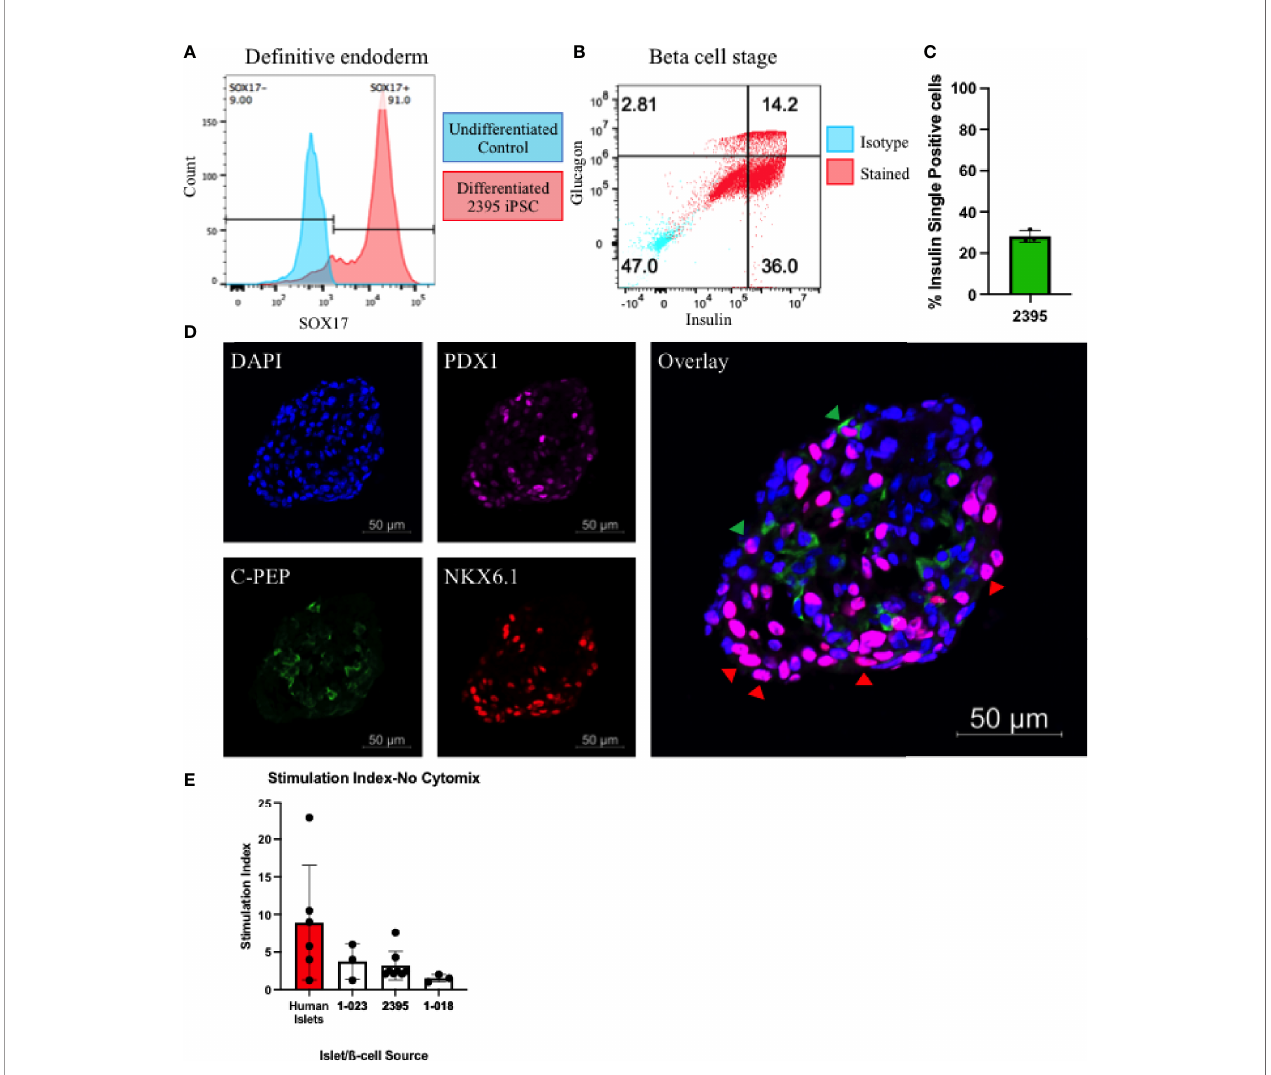
FIGURE 3 | Donor 2395 iPSC differentiate to stem cell derived beta-like cells (sBC). (A) Donor 2395 iPSC upregulate SOX17 when differentiated to de fi nitive endoderm. (B) When donor 2395 de fi nitive endoderm is differentiated to the b -cell stage, many polyhormonal (insulin + glucagon + ) and monohormonal (insulin + ) cells arise. (C) The percent of insulin + glucagon - cells from 3 repeats of 2395 sBC differentiations. (D) An sBC from donor 2395 was fi xed, labeled with DAPI, stained with antibodies against PDX1, C-peptide, and NKX6.1 revealing some C-peptide/NKX6.1 double positive b -cells (green arrow heads) as well as many NKX6.1/PDX1 double positive cells (red arrow heads). (E) Donor 2395 sBC as well as iPS- b -cells from lines 1-018 and 1-023 exhibit glucose-stimulated insulin secretion. Stimulation index = insulin secretion in 16.7mM glucose/insulin secretion in 3mM